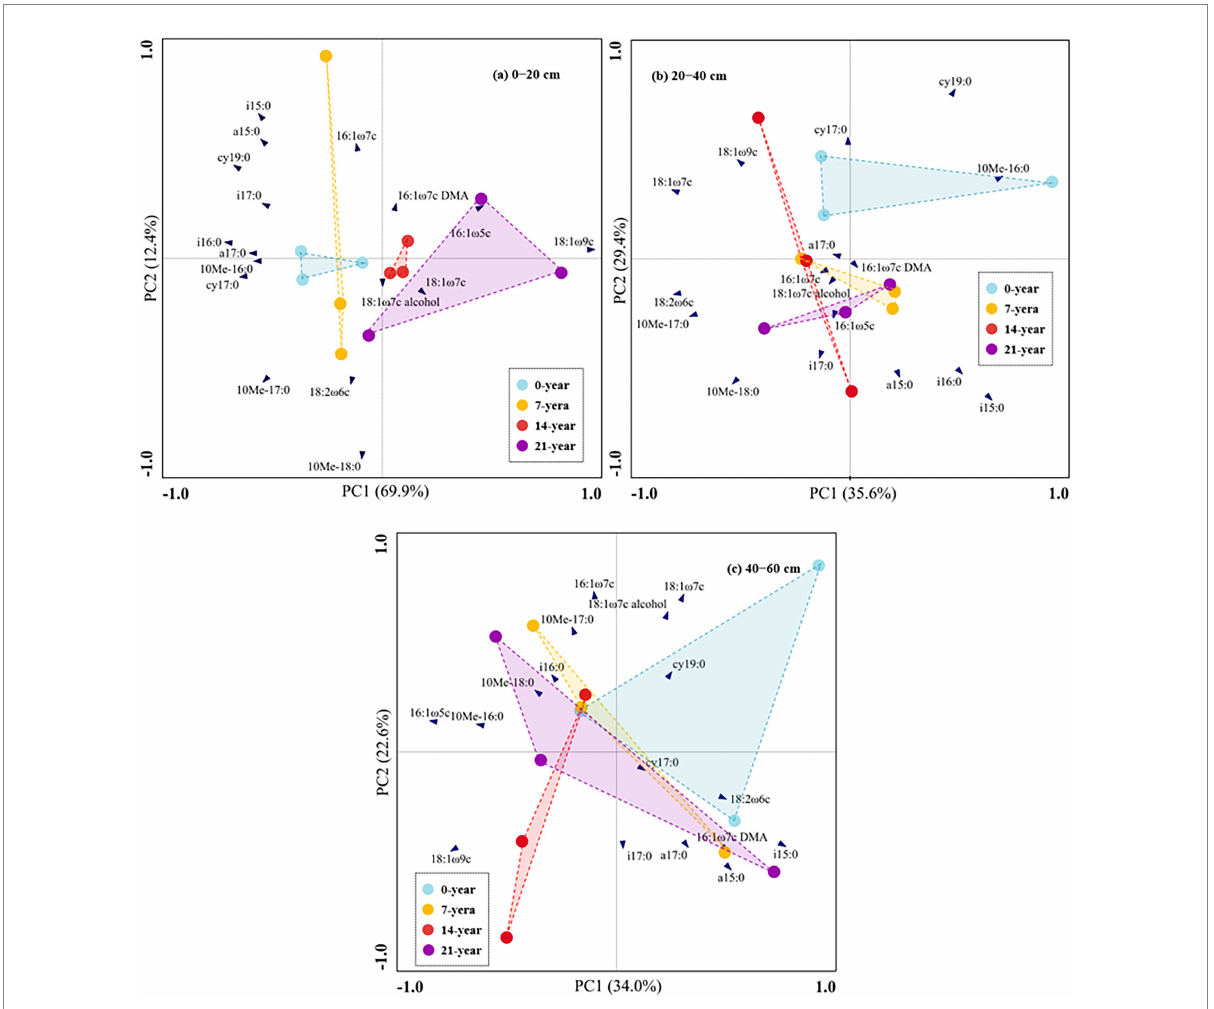
FIGURE 3 Principal component analysis (PCA) based on 19 individual PLFAs in this study across walnut orchards of contrasting ages at the three soil depths ( (A) 0–20 cm, (B) 20–40 cm, and (C) 40–60